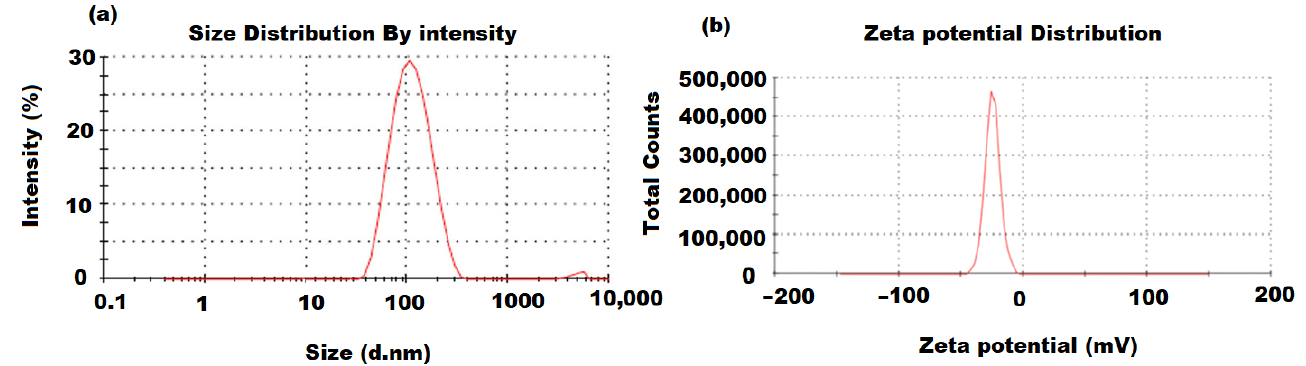
Figure 2. ( a ) Dynamic light-scattering distribution by intensity and ( b ) zeta-potential distribution (mV) of green synthesized ZnONPs using oat biomass.